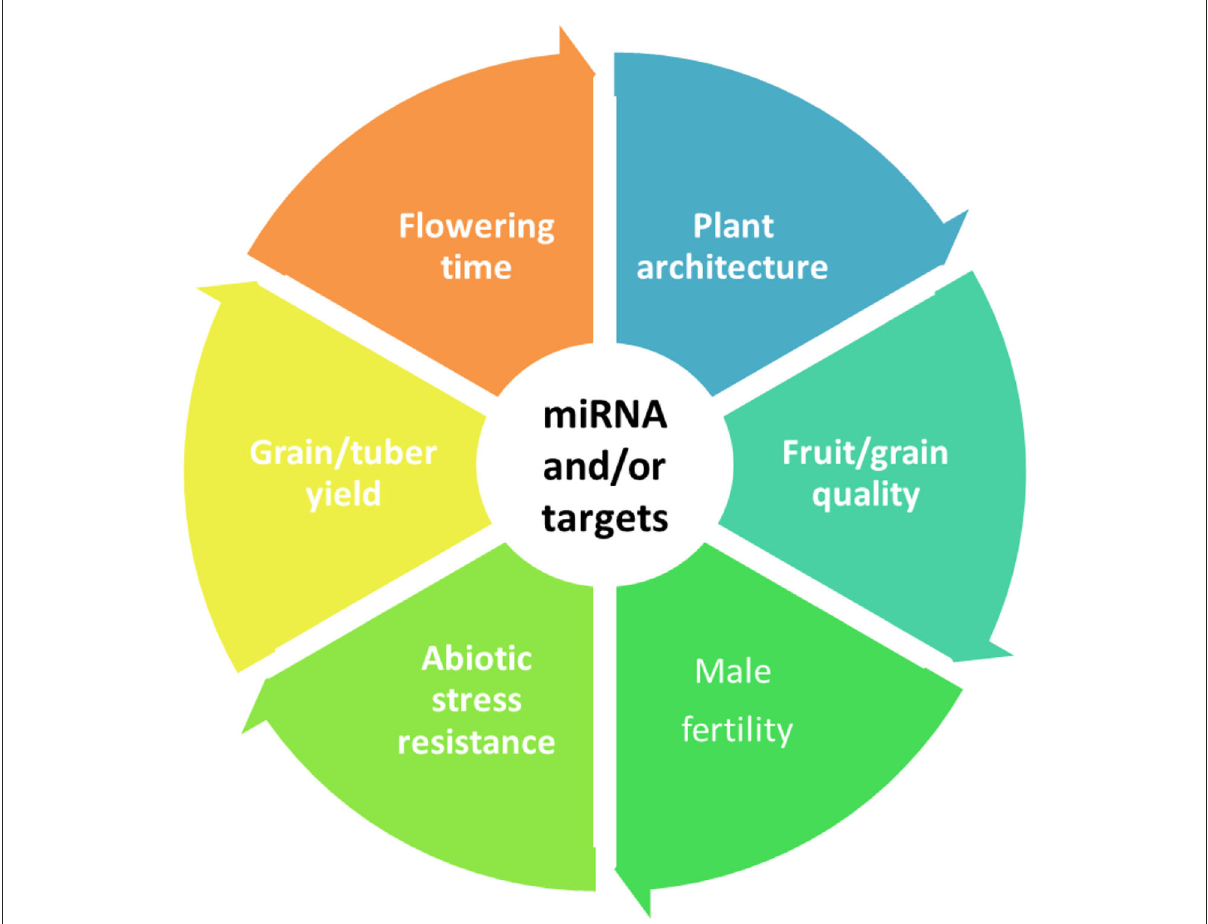
FIGURE5 MiRNAs and/or their target genes regulate multiple agronomic traits of plants. Primarily for quality and yield of agronomic important plant, ideal plant architecture, abiotic stress resistance, male sterility, and flowering time.